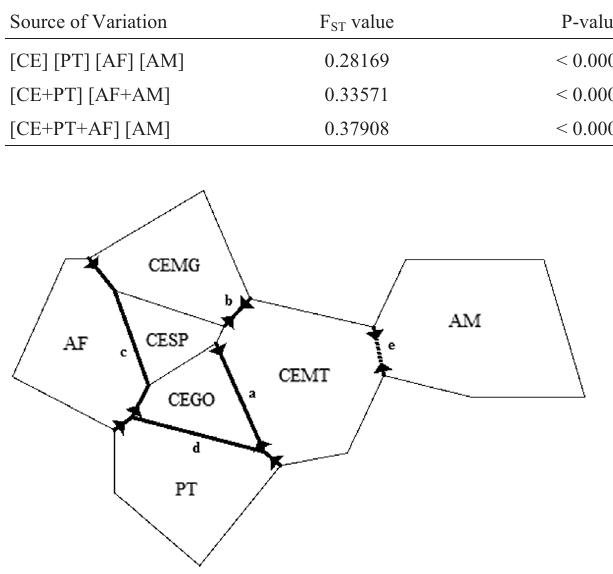
Table 5 - AMOVA with groups of M. tridactyla populations, and percentage of variation within and between groups. Source of Variation Within Groups/Populations